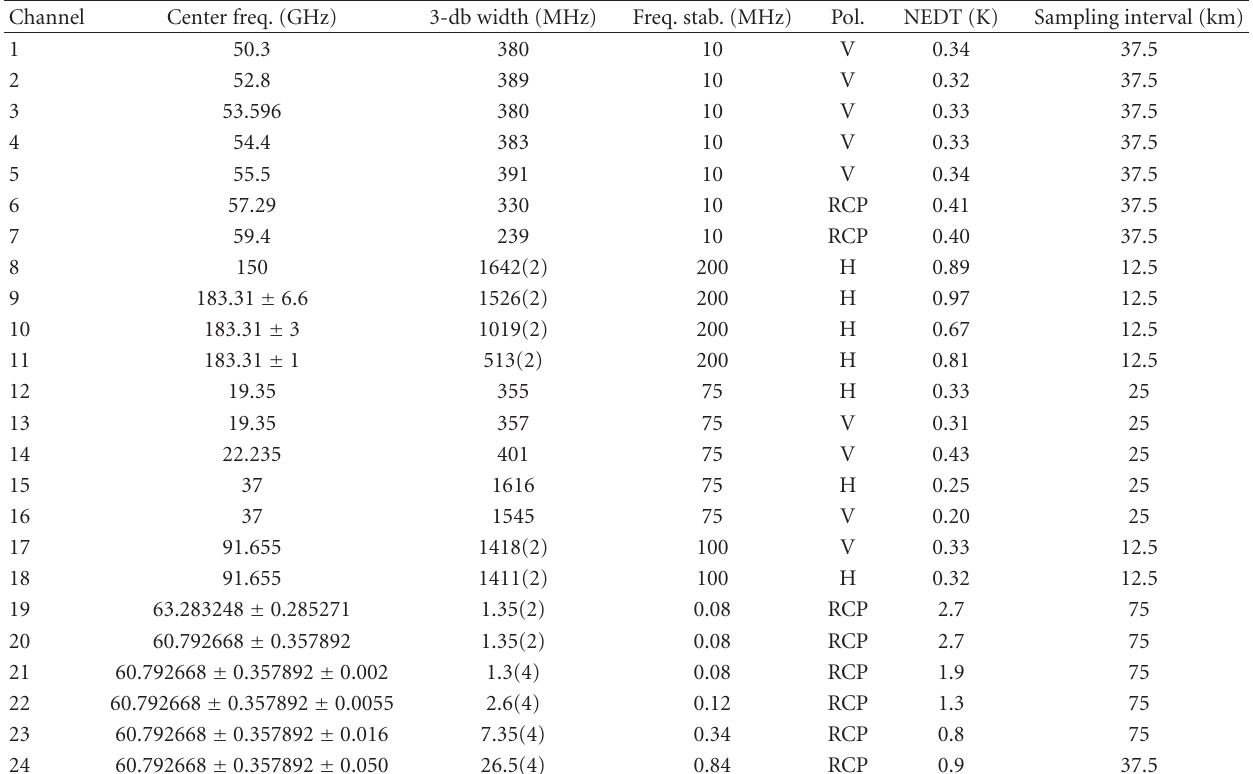
Table 1: Channel characteristics of SSMIS sensor [1]. ((1) Sampling refers to along scan direction based on 833km spacecraft altitude. (2) NEDT for instrument temperature 0 ◦ C and calibration target 260 K with integration times of 8.4 msec for Channels 12–16; 12.6 msec for Channels 1–7, 24; and 25.2 msec for Channels 19–23 and 4.2 msec for Channels 8–11, 17-18. (3) Number of subbands is indicated by ( n ) next to individual 3-db width. (4) RCP denotes right-hand circular